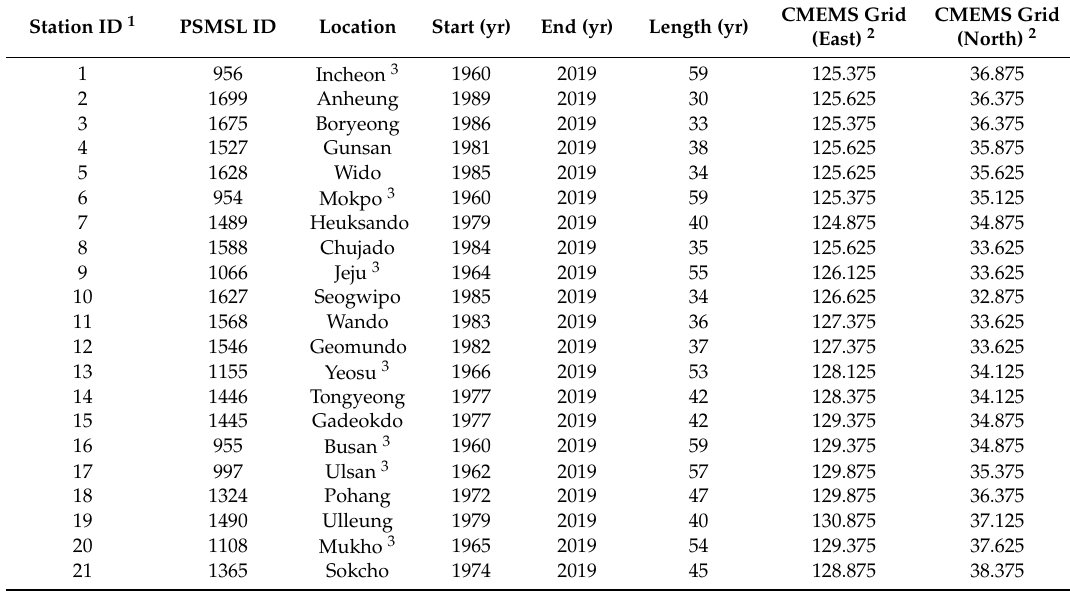
Table 1. Summary of tide gauge and satellite altimeter data used in this